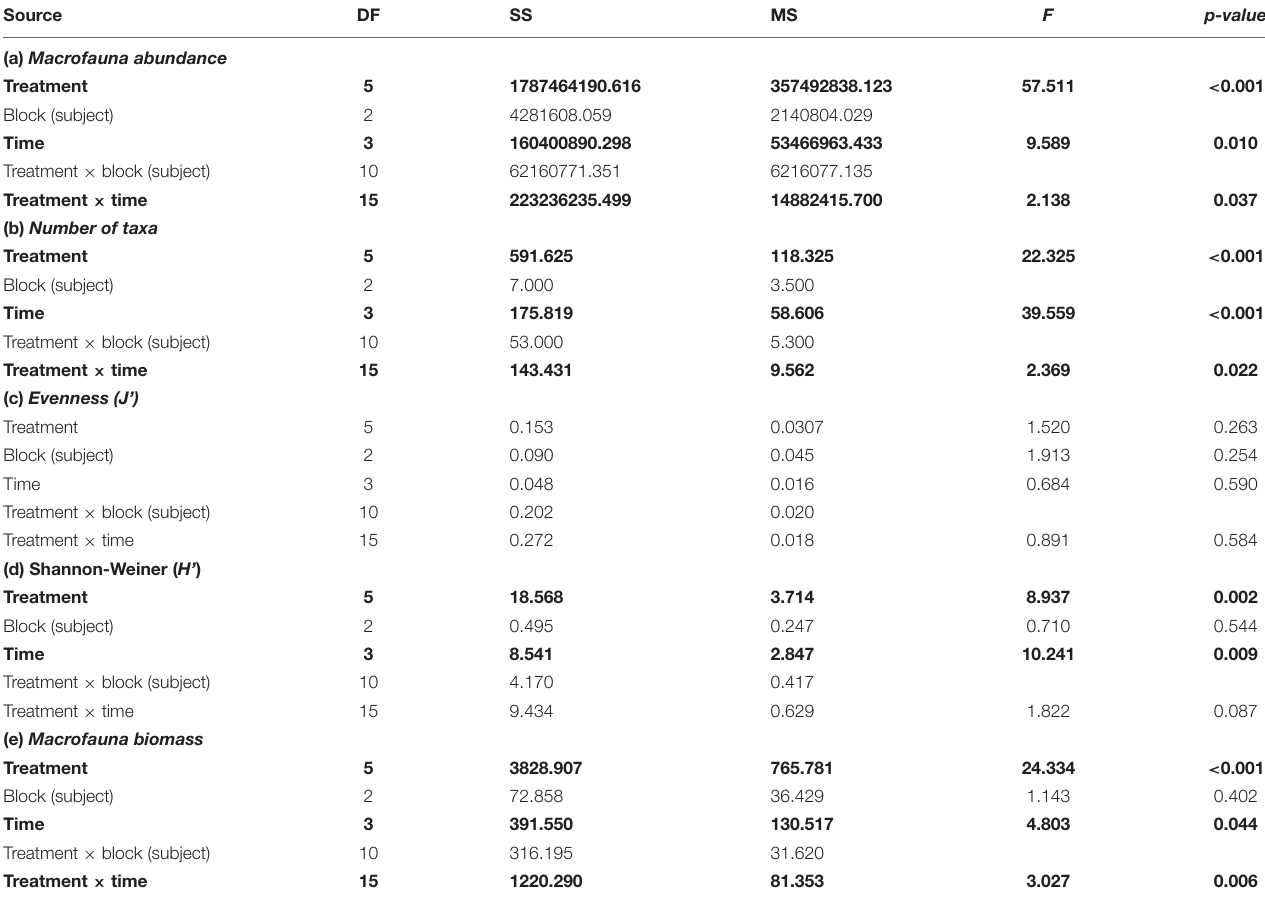
TABLE 1 | Results from two-way repeated measures ANOVA on univariate indices. Source DF SS MS F